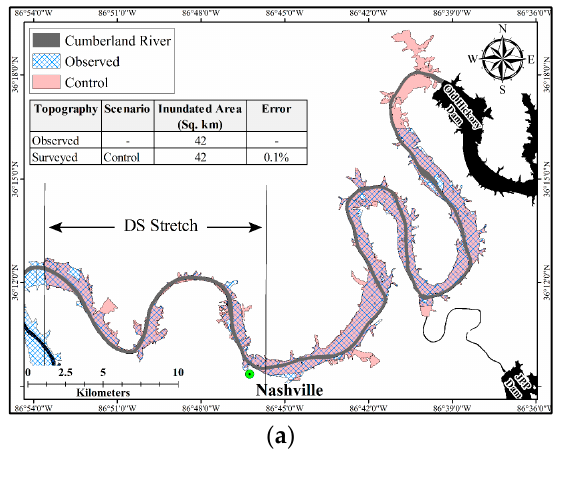
Figure 6. ( a ) Hydrograph for observed and simulated stage at Nashville location; ( b ) performance of the simulated water surface elevation (WSE).